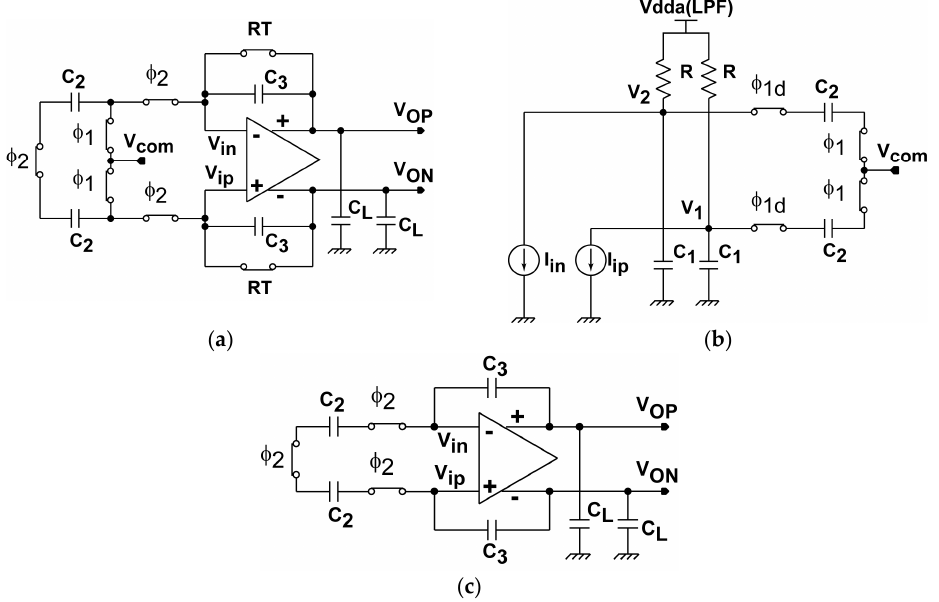
Figure 9. Phase diagrams of the lock-in readout circuits: ( a ) reset phase; ( b ) sampling phase ( c ) transfer phase.